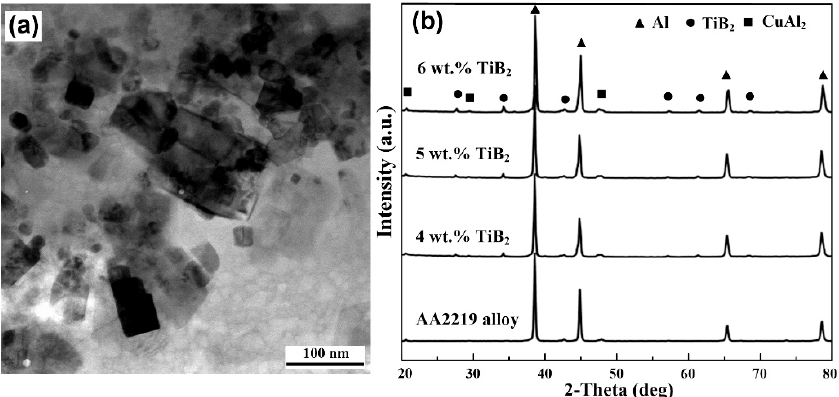
Figure 3. ( a ) TEM image of nanosized TiB 2 particles, ( b ) XRD pattern for the alloy and composites.